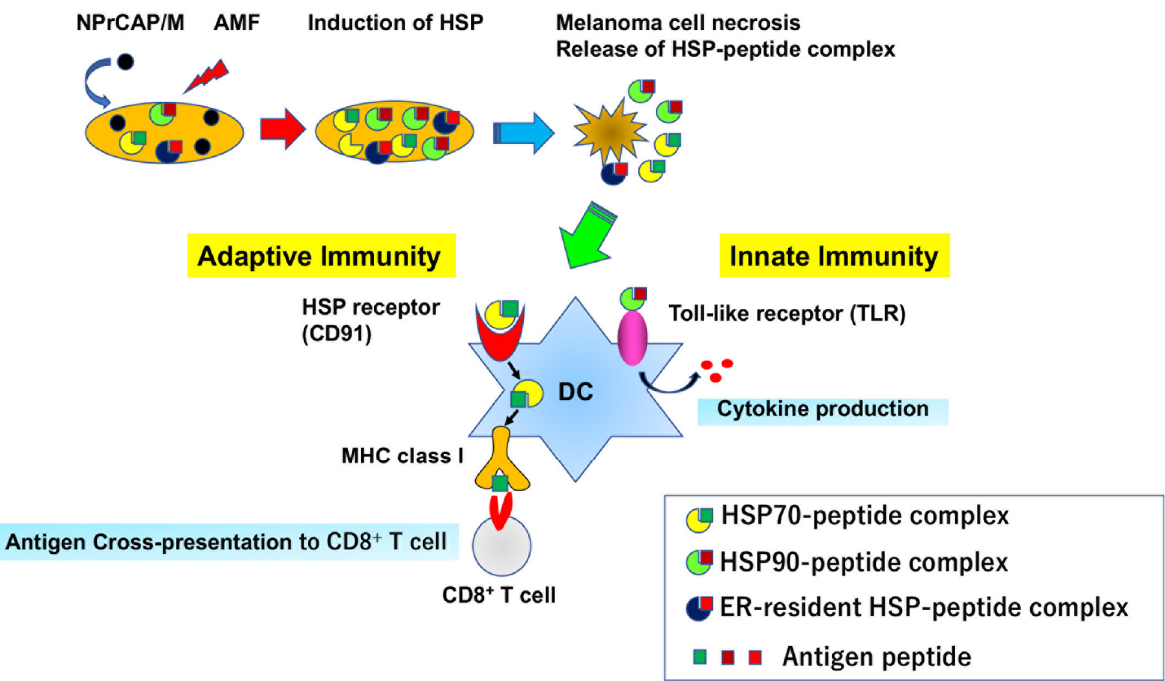
Figure 9. CTI therapy orchestrates the innate and adaptive immunity via production and release of HSP-peptide complex in melanoma cells.